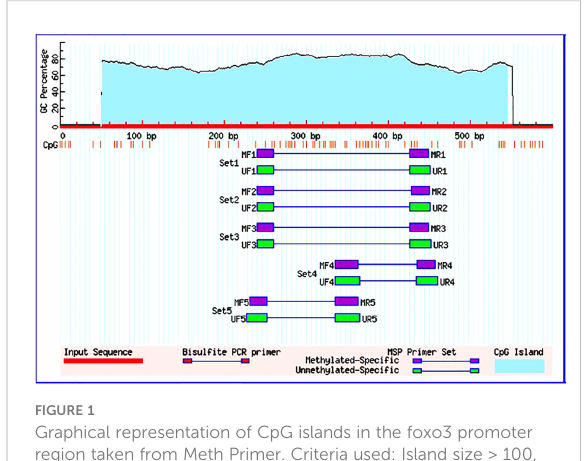
FIGURE 1 Graphical representation of CpG islands in the foxo3 promoter region taken from Meth Primer. Criteria used: Island size > 100, GC Percent >50.0, Obs/Exp>